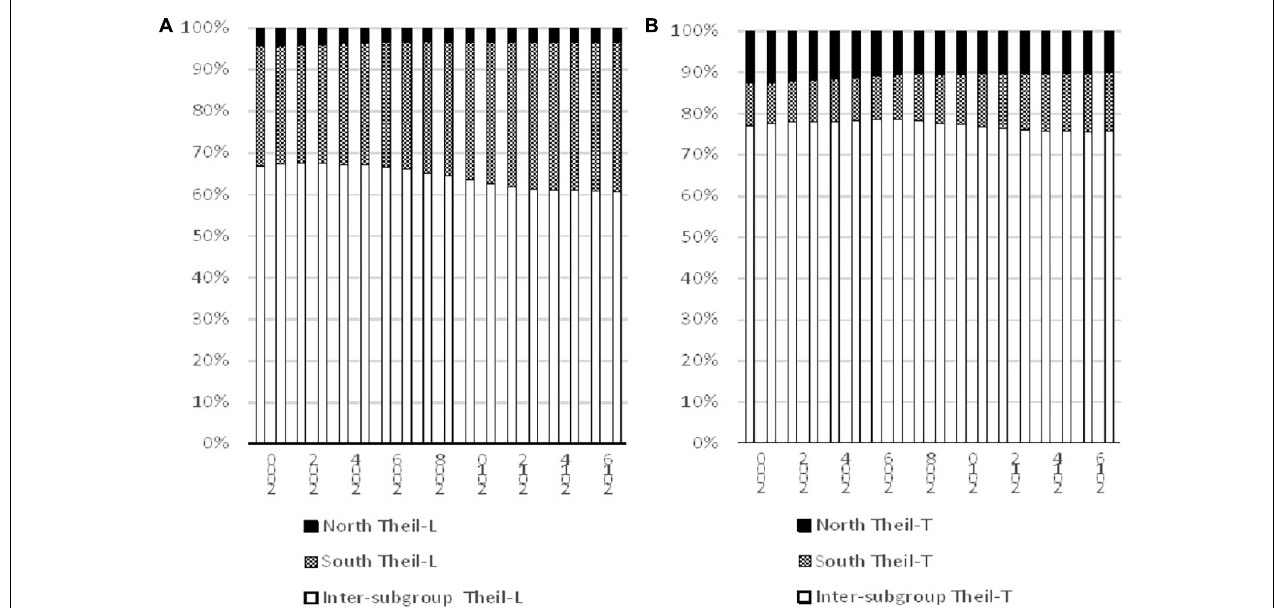
FIGURE 3 | Decomposition of inequality for the North and South, 2000–2017. Source: Authors’ calculation.